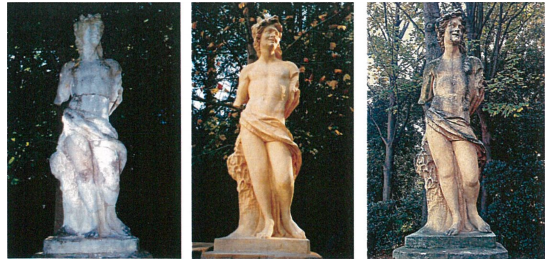
Figure 3. Photographies of the statue un 1999 before restorations, after restorations, and in